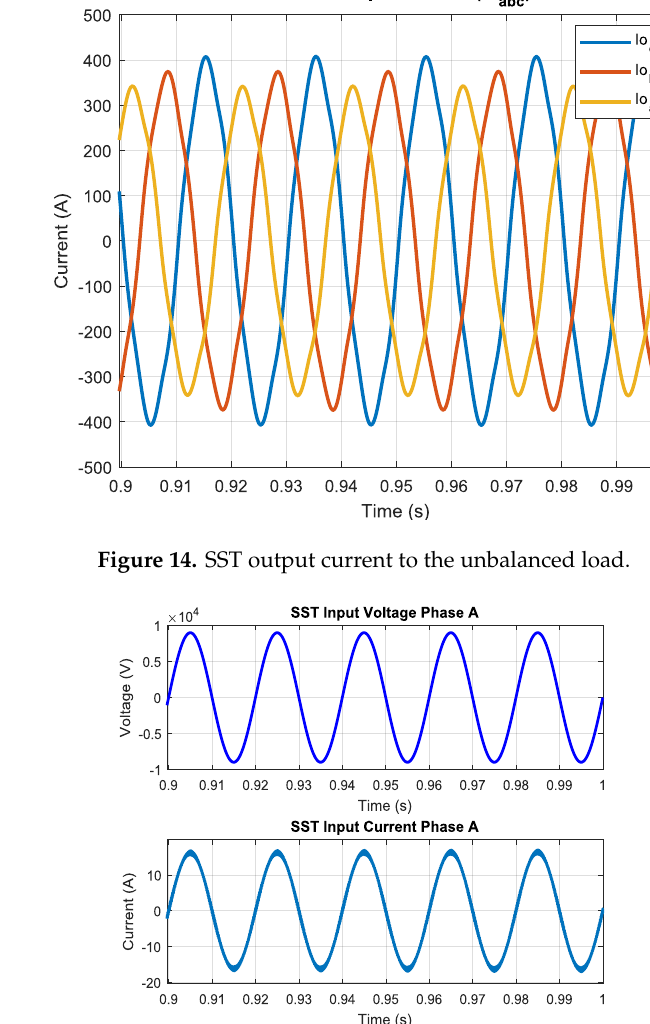
Figure 15. Result displaying that phase A voltage and current are in phase.